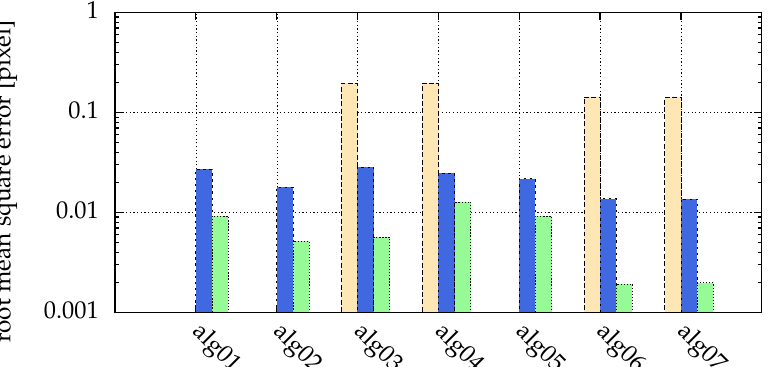
Figure 5. Comparison of different strengths of additive white Gaussian noise: yellow ( (cid:4) ) bars for SNR = 10, blue ( (cid:4) ) for SNR = 100 and green ( (cid:4) ) for SNR = 1000. Missing bars imply that not all particles where correctly detected (for SNR = 5, this was the case for all algorithms). The ordinate shows the root mean square error of the distance between detected and real positions. There was no salt and pepper noise. The statistics/simulation was done with images containing 10,000 particles with σ { x , y } =